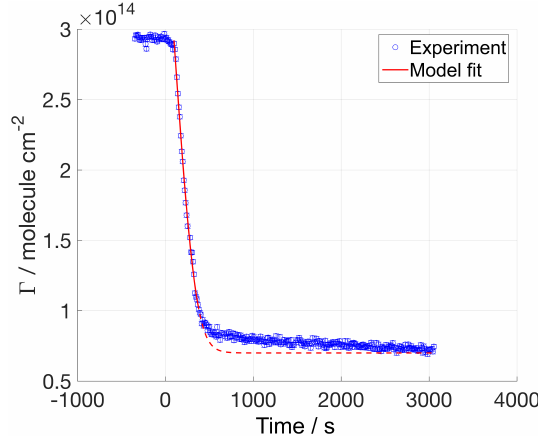
Figure 3. Oleic acid ( d 34 OA) exposed to [NO 3 ] = 86ppt. The red line illustrates the fit obtained from our kinetic modelling. The solid section of the red line indicates the data range used for the optimi- sation of the kinetic parameters; the dashed section of this line illus- trates the modelled final part of the decay, but these data were not used in the optimisation of the fitting since below a certain surface excess the molecules rearrange with a different orientation with re- spect to the interface. The experimental data are displayed with er- ror bars but they are of the same scale as the marker size and hence not clearly visible; these experimental uncertainties were used in the fitting procedure to calculate the value of χ 2